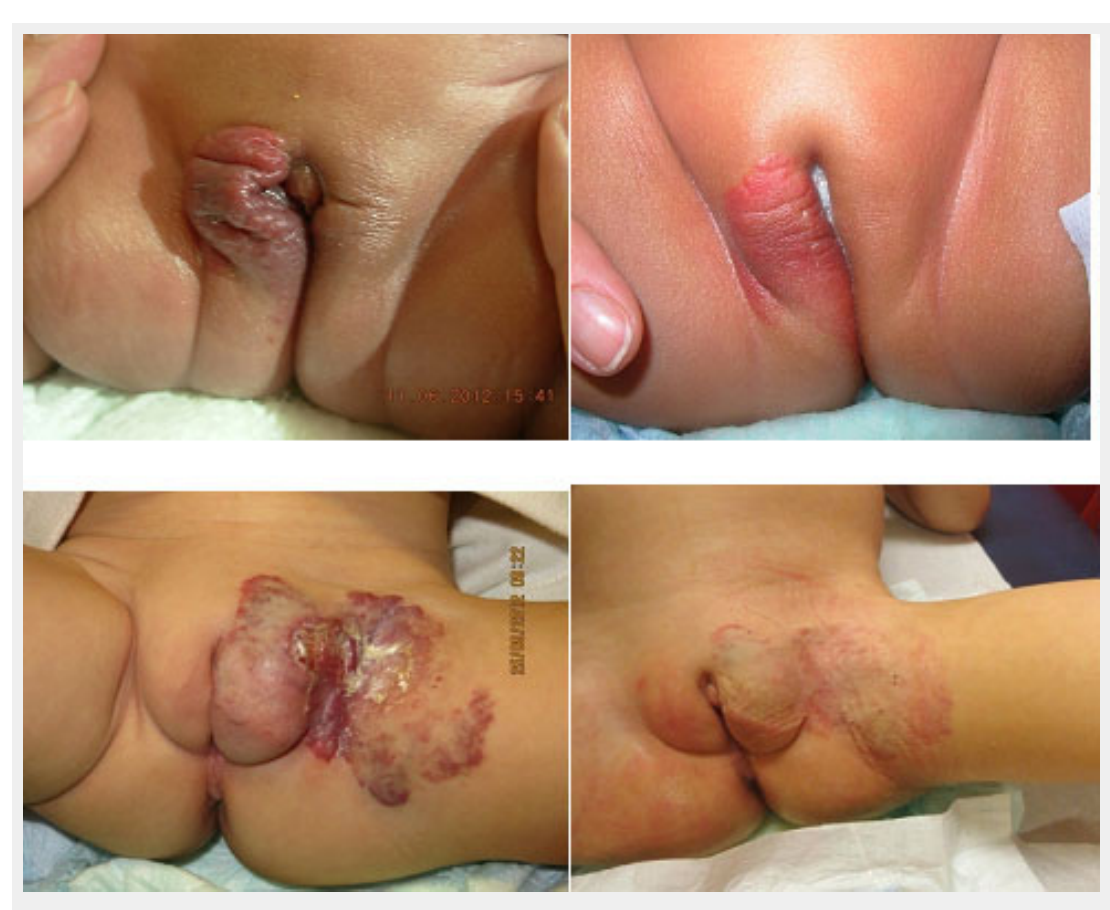
Figure 2 Two examples of genital area haemangiomas complicated by ulceration. Left: before treatment. Right: after treatment with propranolol (2 mg/kg/